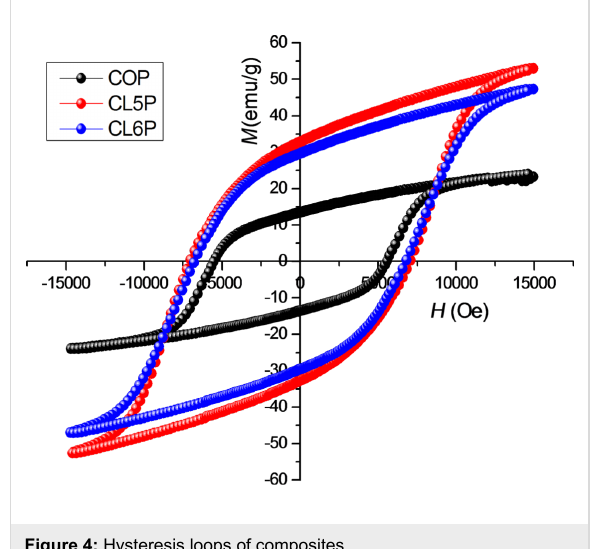
Figure 4: Hysteresis loops of composites.